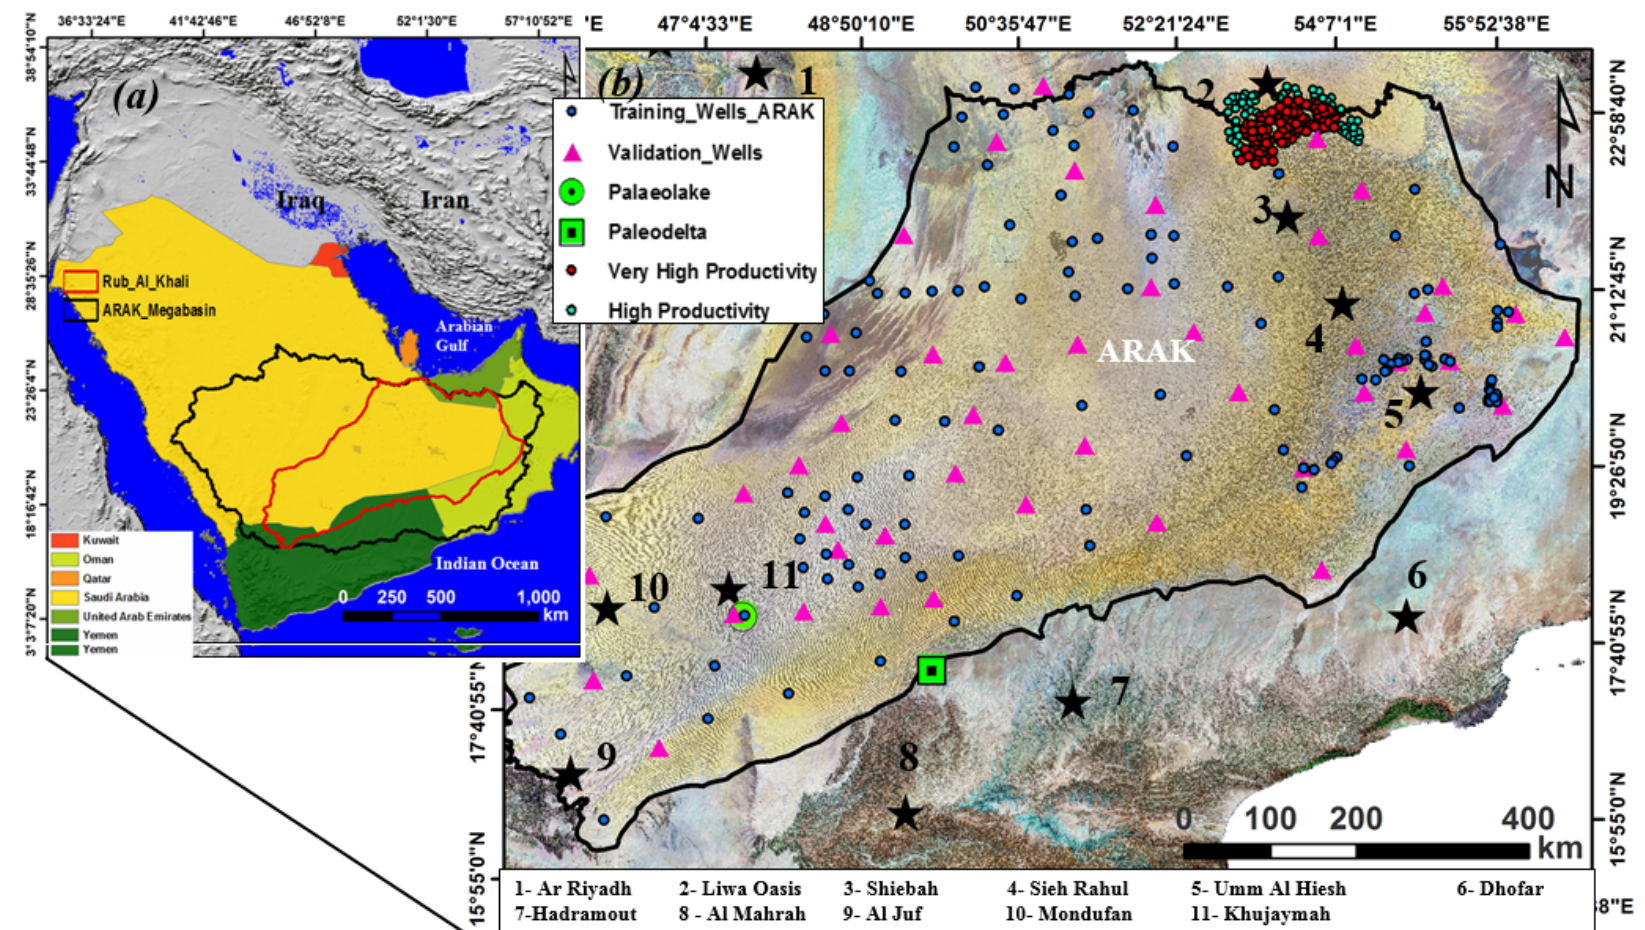
Figure 1. Maps of the Arabian Peninsula ( a ), and RGB 652 band combination of Landsat image of Ar Rub Al Khali mega-basin (black polygon) and Ar Rub Al Khali (ARAK) aquifer underneath sand sheets (red polygon) ( b ), red and black points highlight city and groundwater well locations, respectively. Green points highlight locations of the discovered paleolakes [2,3].